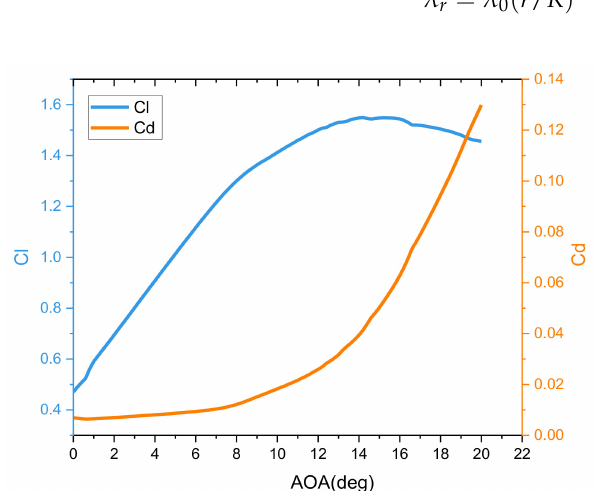
Figure 3. The variation of Lift ( Cl ) and drag ( Cd ) coefficients with the angle of attack.